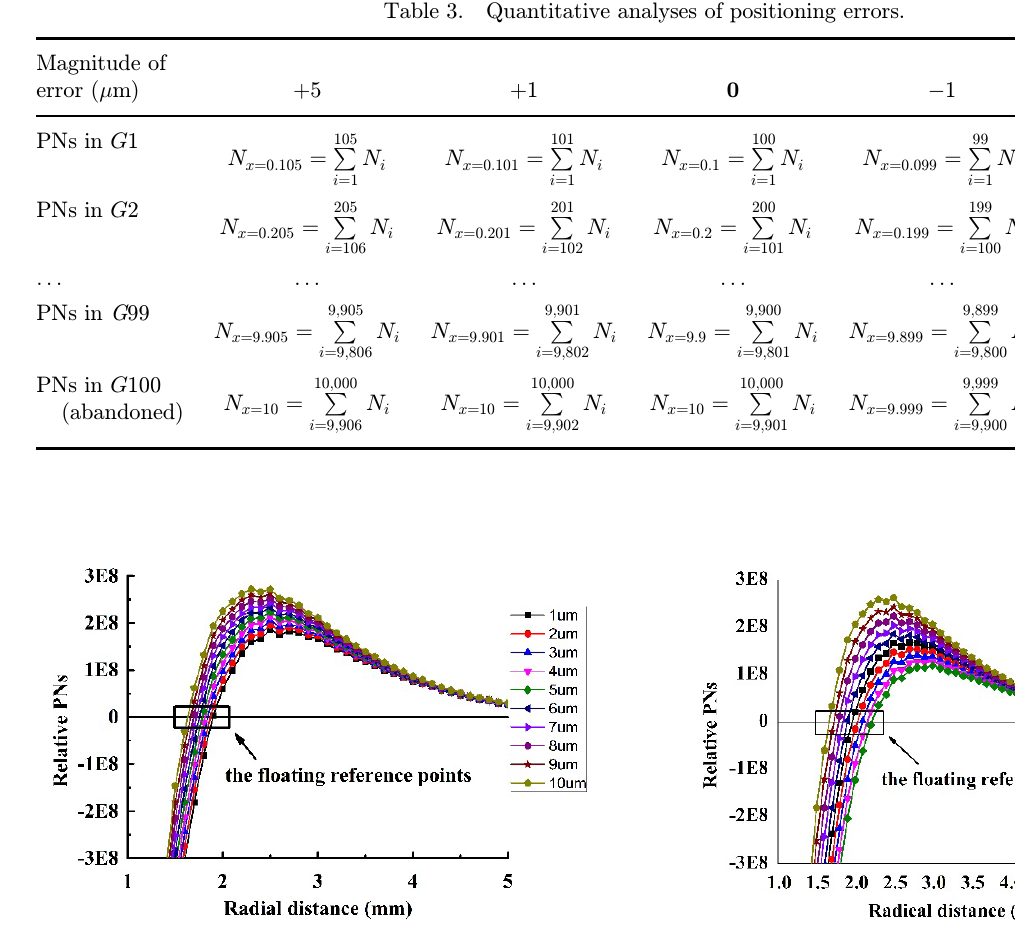
Fig. 4. The FRPs with positioning errors at di®erent levels by simulation.